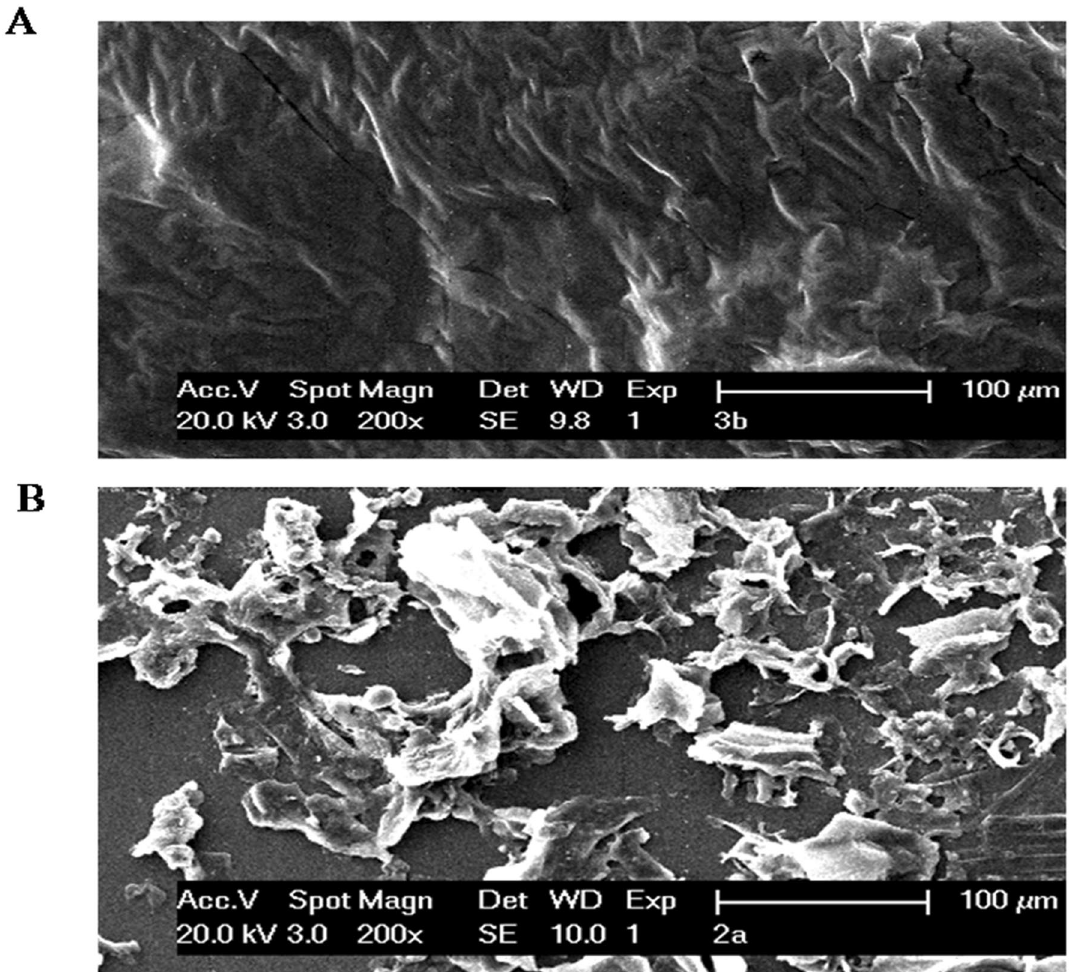
Figure 2. Scanning electron micrographs of Musa paradisiaca (Robusta- AAA) banana peel ( A ) enzyme treated and ( B ) control (scale bar = 100